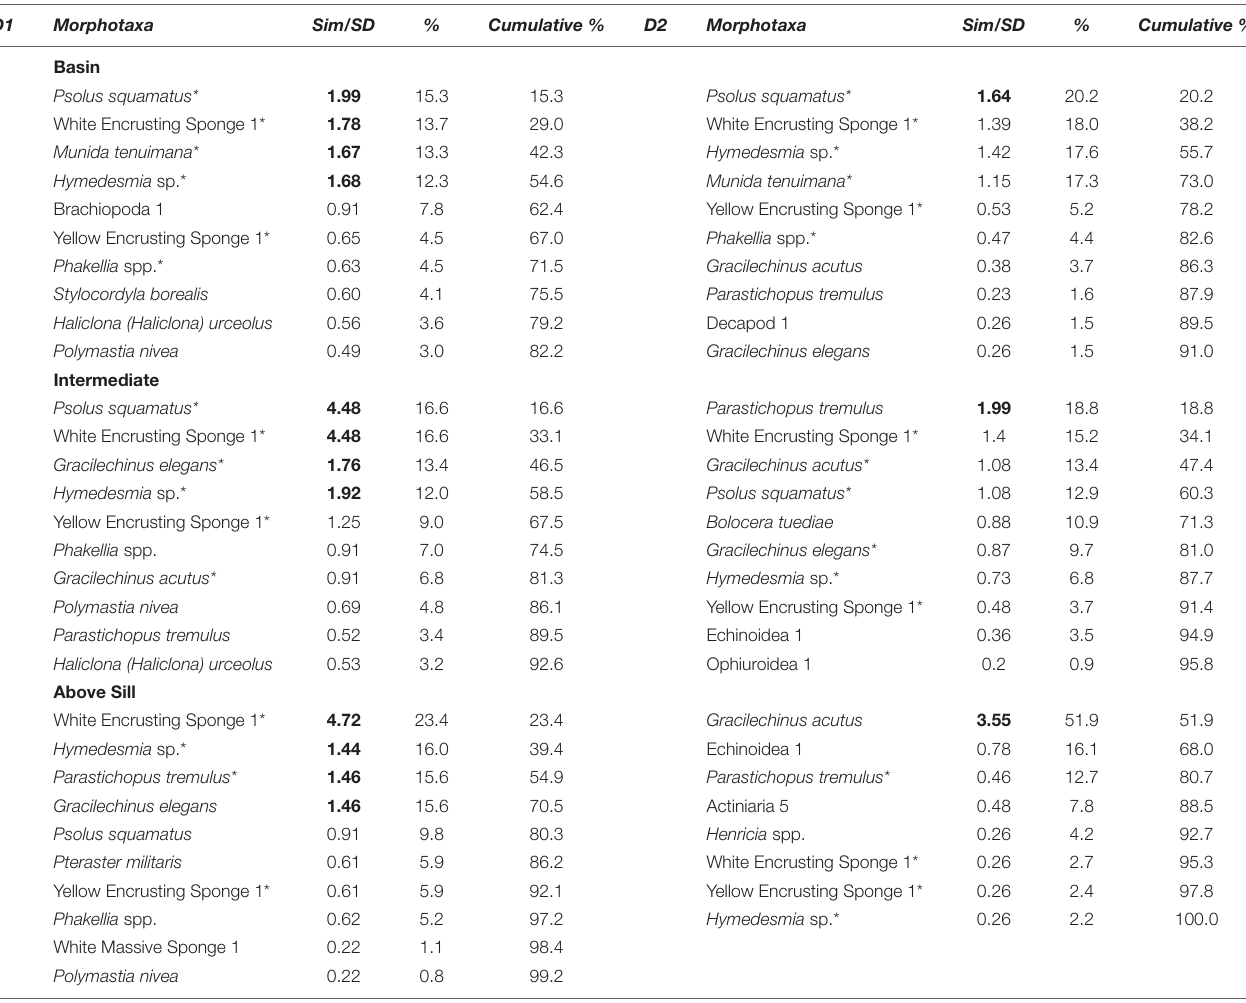
TABLE 3 | Taxa responsible for the differences in the top 10 highest contributing megafauna within each zone identified in the similarity percentage analysis (SIMPER) for Dive 1 (Left) and Dive 2